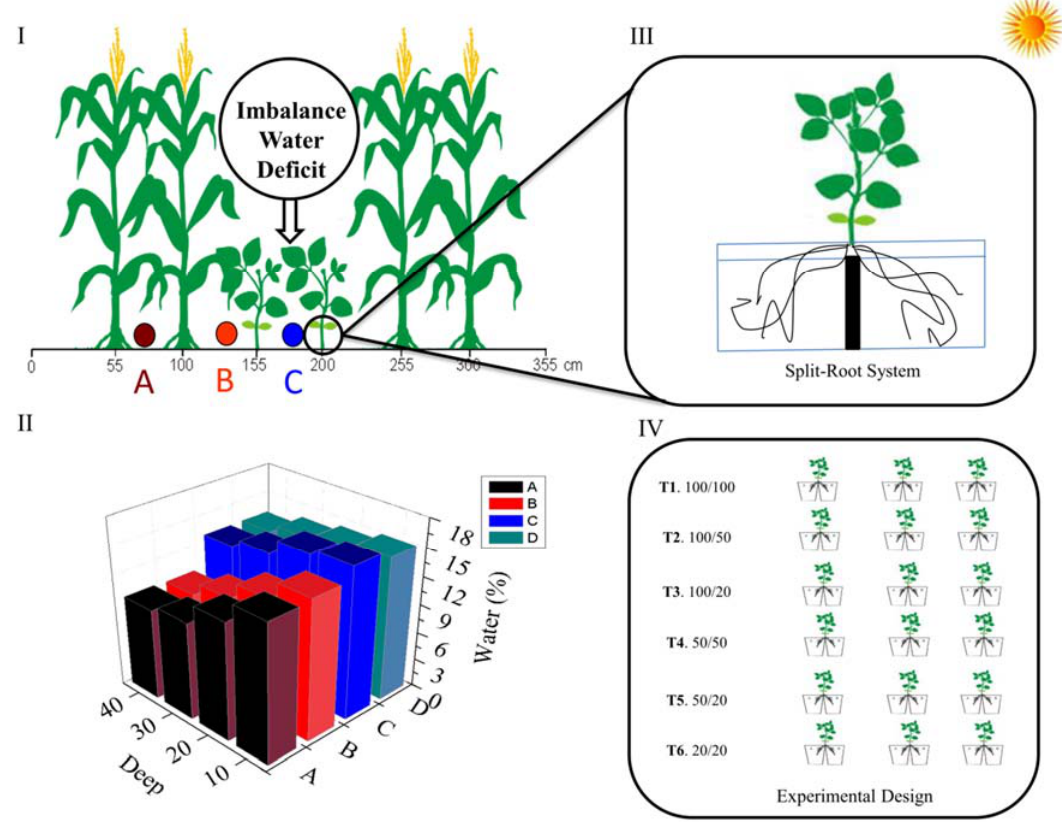
Figure 1. ( I ) Schematic representation of maize soybean inter cropping and water imbalance site. ( II ) Soil water contents of different spatial position in maize ‐ soybean relay intercropping system. A stands for narrow maize rows, B stands for between maize and soybean, C represents the soybean lines while D shows the soybean sole crop. ( III ) Split ‐ root approach as a tool to study the effects of imbalance water deficits. ( IV ) Schematic representation of soybean experiment design.